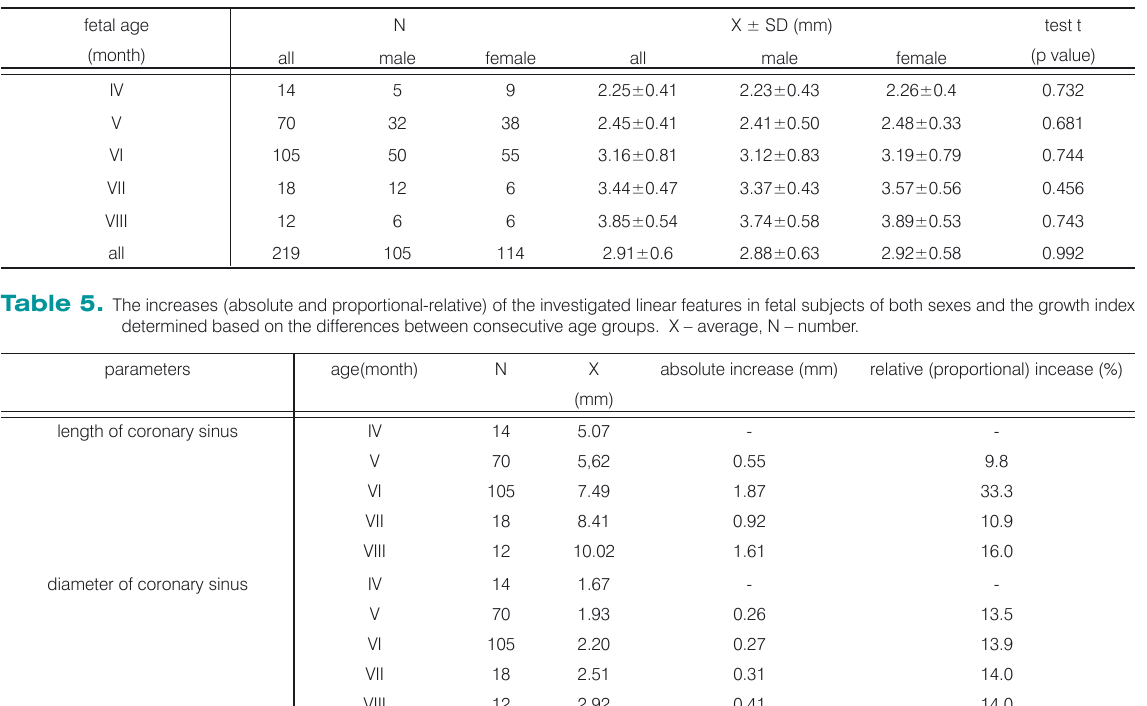
Table 4. The total sum of the diameters of the cardiac veins that drain into the coronary sinus (the great cardiac vein, the posterior cardiac vein, the left atrial oblique vein, the middle cardiac vein and the small cardiac vein) shown in relation to the age of the subjects in the particular subgroups. N - number, X – average, SD – standard deviation, test t-Student show gender differences.